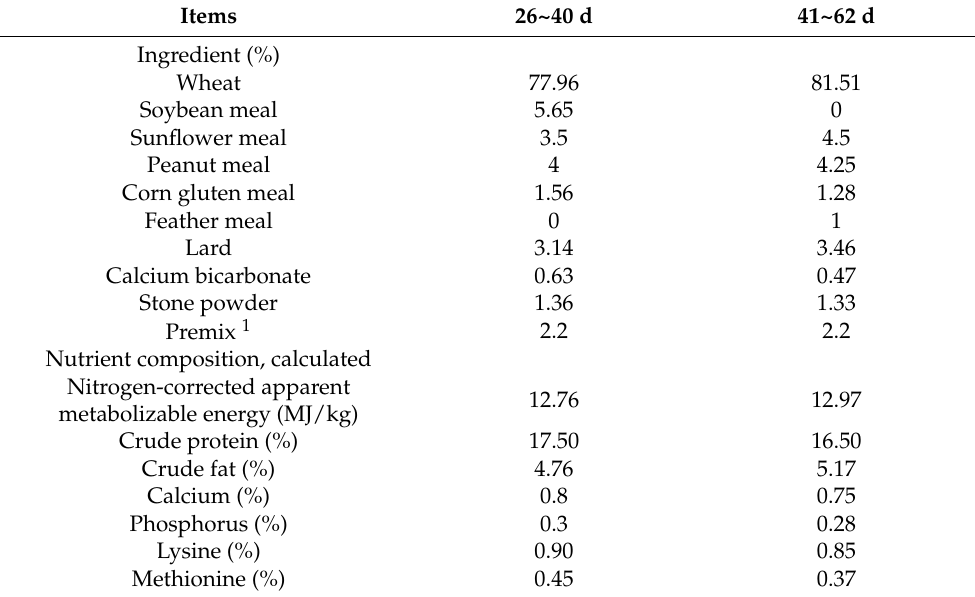
Table 1. The composition and nutrient levels of the experimental